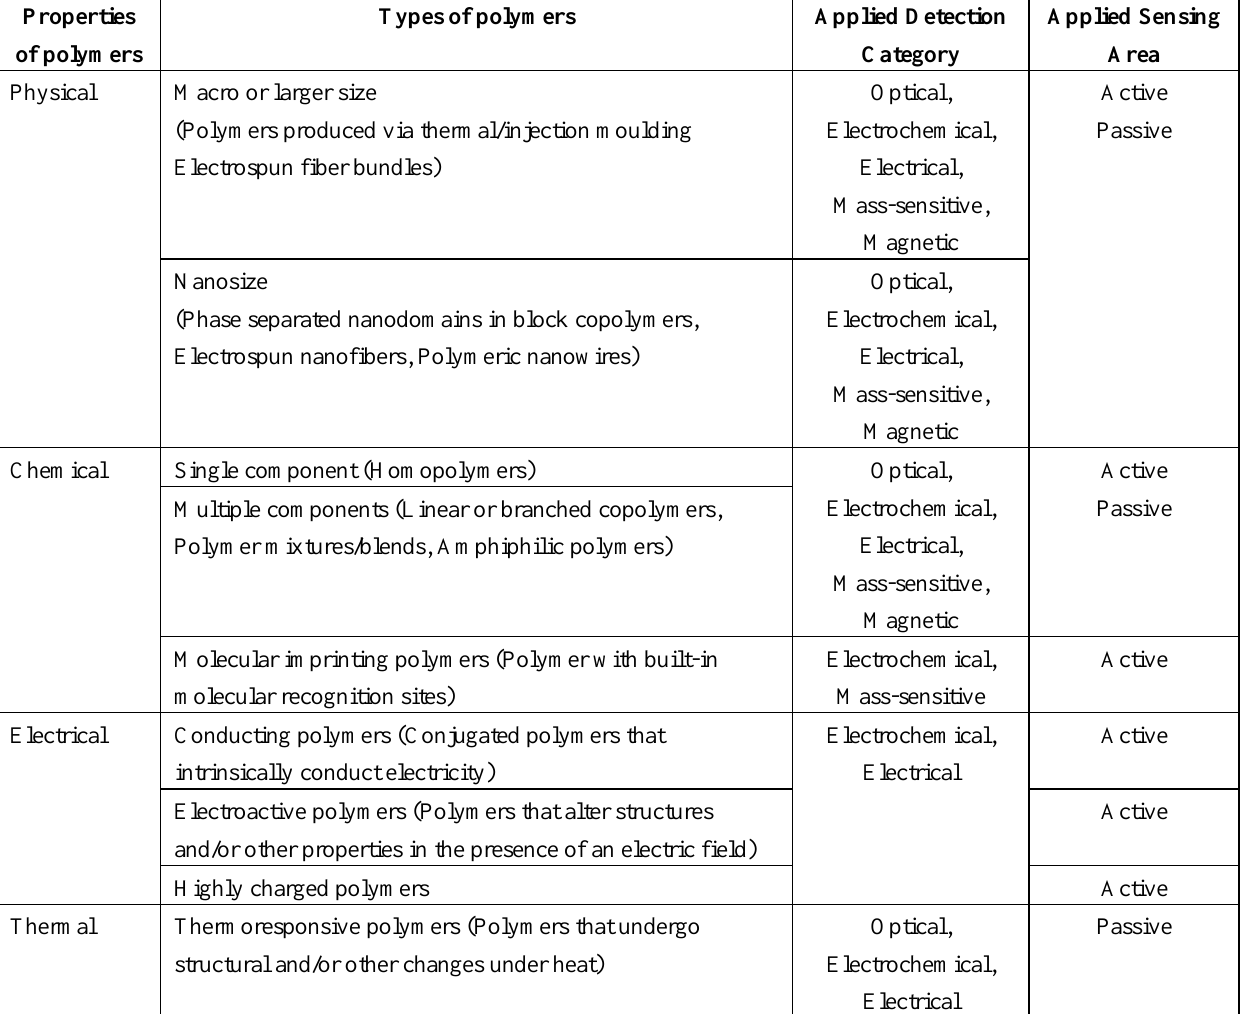
Table 2. Properties of polymers exploited in different types of protein sensors as well as sensor regions of applied